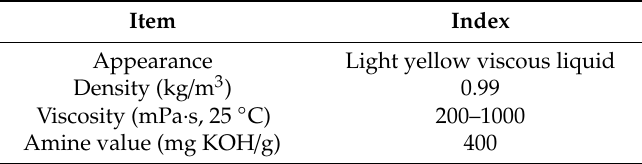
Table 2. Curing agent technical index.